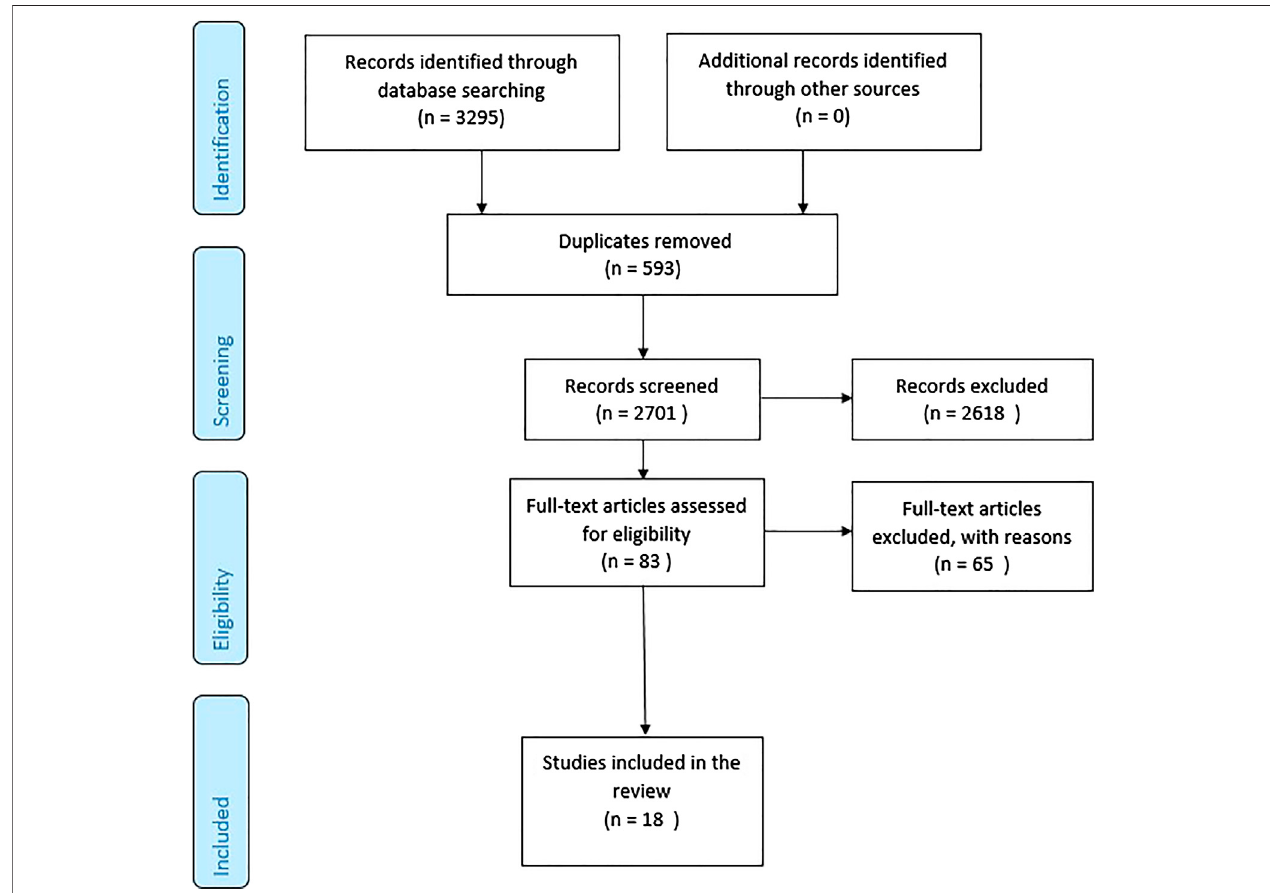
FIGURE 2 | PRISMA fl ow